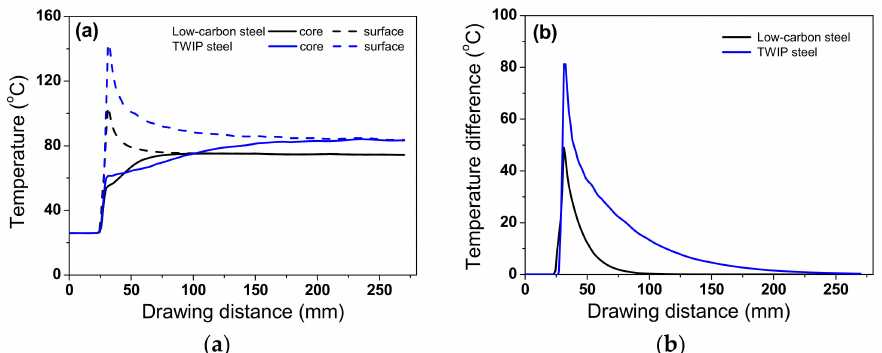
Figure 9. Comparison of numerical simulation results of ( a ) temperature profiles along the drawing direction at core and surface regions and ( b ) temperature difference between core and surface regions of low-carbon and TWIP steels.